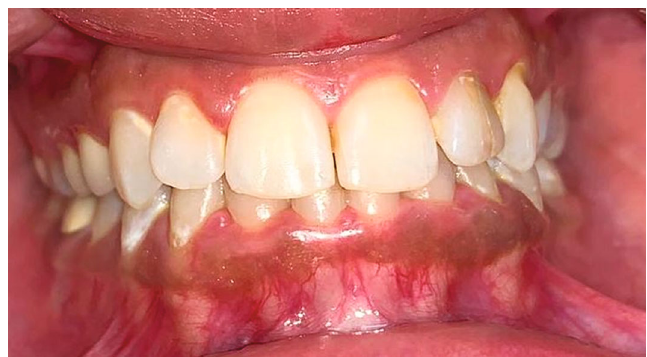
Figure 1: Preoperative picture of moderate gingival